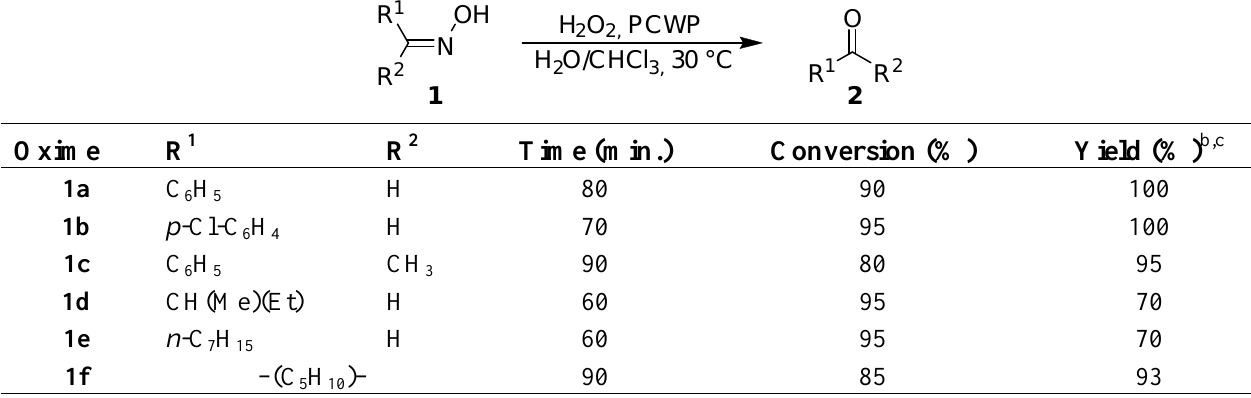
Table 1. Deoximation of aldoximes 1 by oxidation with diluted hydrogen peroxide and PCWP